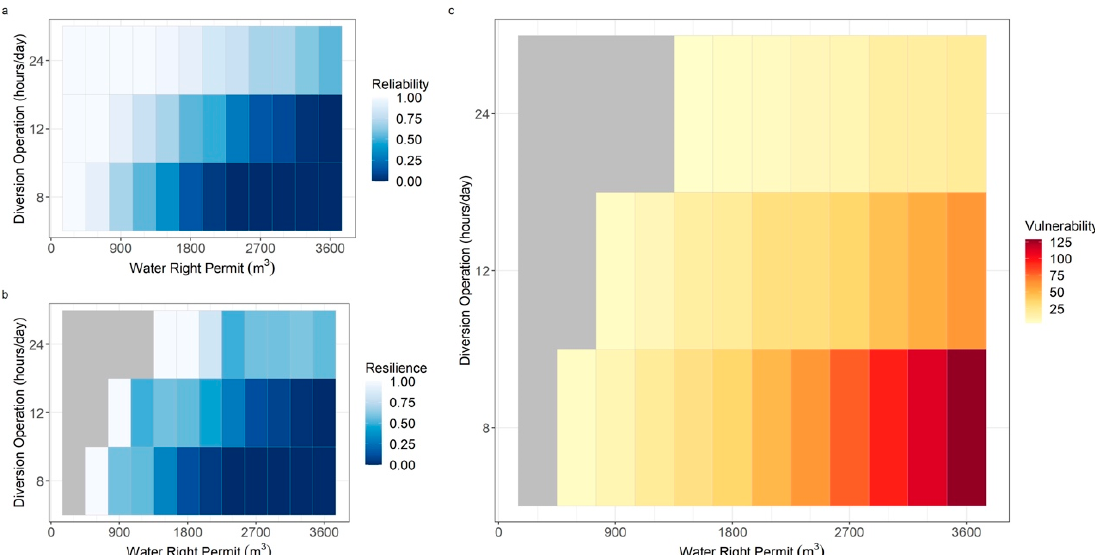
Figure 5. Water resource performance metrics (reliability, resilience, vulnerability) for surface water availability between 1980–2019, including: ( a ) the likelihood of securing a full water right permit volume, ( b ) the likelihood of securing a full water right permit following a year where the full permit volume was not secured, and ( c ) the average of additional diversion days needed to secure a full water right permit volume in the case of a shortage.